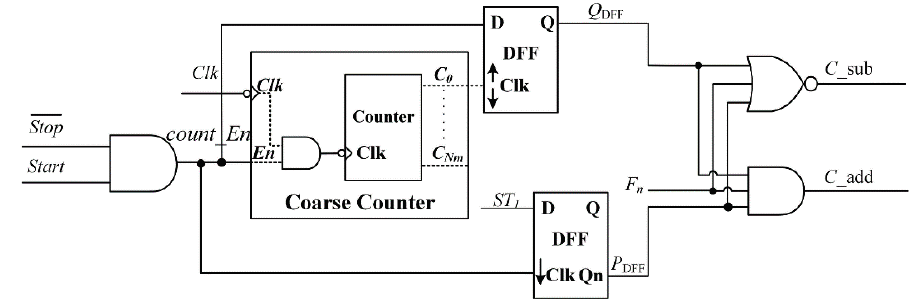
Figure 11. Block diagram of the proposed calibration